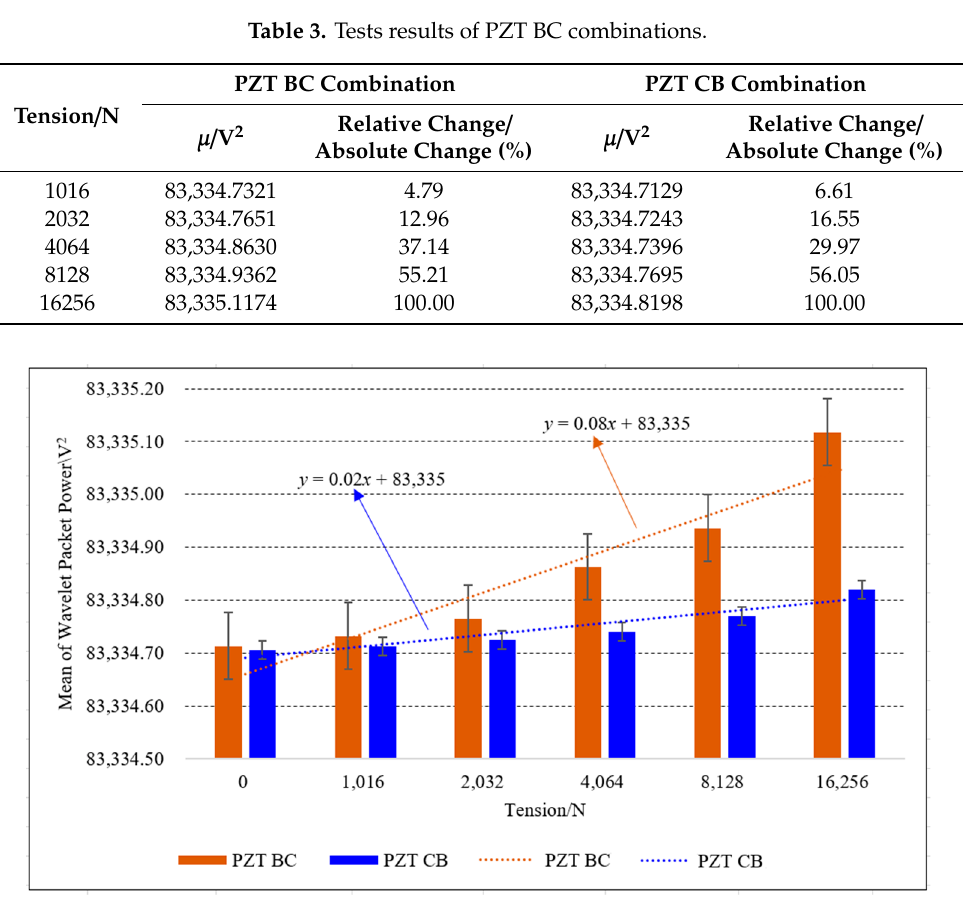
Table 3. Tests results of PZT BC combinations.